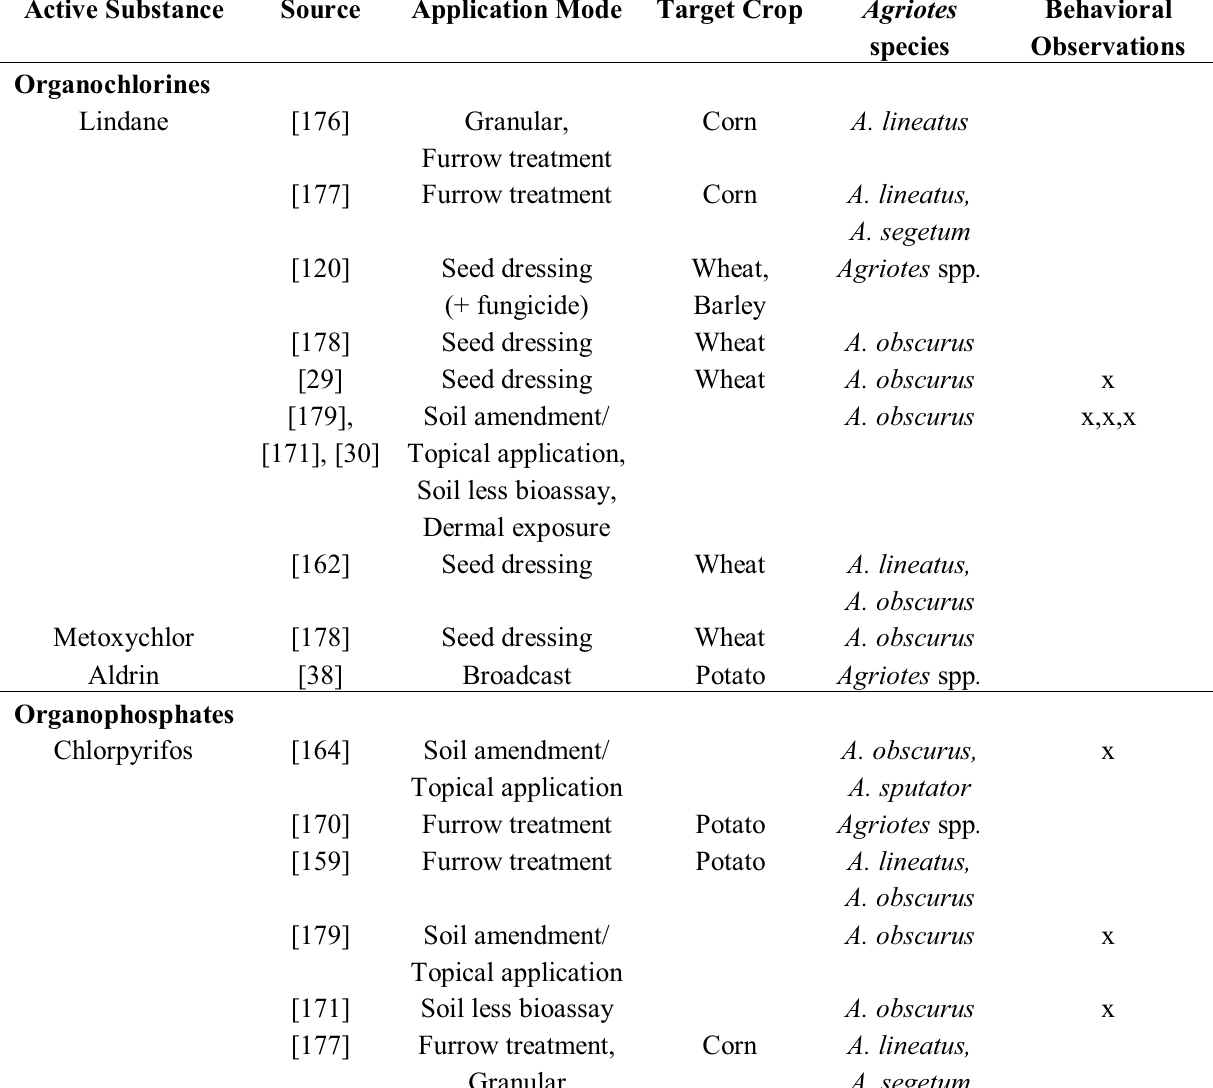
Table 1. Insecticides tested against Agriotes since 1990, with sources, mode of application, protected crop, Agriotes species (whenever possible) and specific behavioral observations (sublethal effects, such as morbidity, lowered activity and recovery periods or